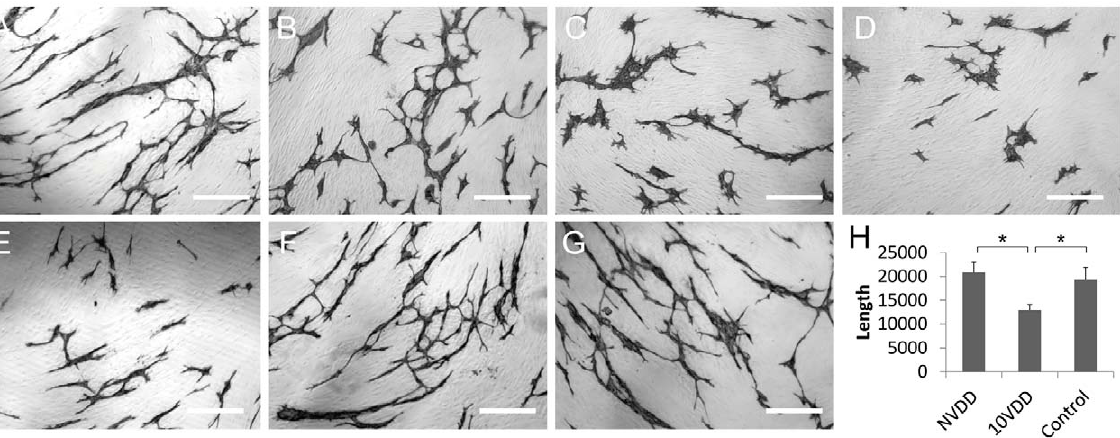
Figure 2. The activity of vasohibin-1 by an endothelial cell tube formation assay. The activity of vasohibin-1 was confirmed by an in vitro endothelial cell tube formation assay. Vasohibin-1 suppressed the HUVEC tube formation in a dose-dependent manner. Representative results of HUVEC tube formation treated with 2 nM VEGF combined with 0 (A), 0.2 (B), 2 (C), and 10 nM vasohibin-1 (D) are shown. Bars indicate 100 m m. The released vasohibin-1 from the device showed comparable results to native activity (E). Significant suppression of HUVEC tube formation was observed in released vasohibin-1 when compared to those treated with NVDD (F) and with only 2 nM VEGF without vasohibin-1 (G). (H) shows the average of each experiment; significantly fewer CD31-positive points were observed in released vasohibin-1-treated wells when compared to those of the vehicle released from NVDD (p , 0.0001) or the VEGF-treated control (p , 0.0001). The vasohibin-1 released from the device showed activity comparable to the native vasohibin-1. Vertical bar indicates total length of tube formation. NVDD: non-vasohibin-1 (vehicle) delivery device, 10VDD: